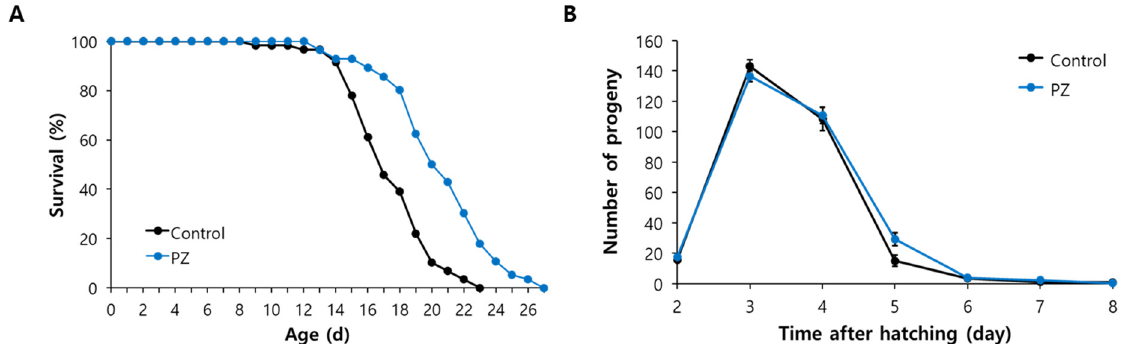
Figure 2. Effects of phlorizin on lifespan and fertility of C. elegans. ( A ) Lifespan assay was performed with sixty age-synchronized worms. Live and dead worms were counted daily and killed/lost/bagged worms were excluded from data analysis. ( B ) Time-course distributions of progeny number produced were compared between untreated control and worms treated with phlorizin during a gravid period (n = 12). Error bar indicates standard error. PZ, phlorizin (10 µ